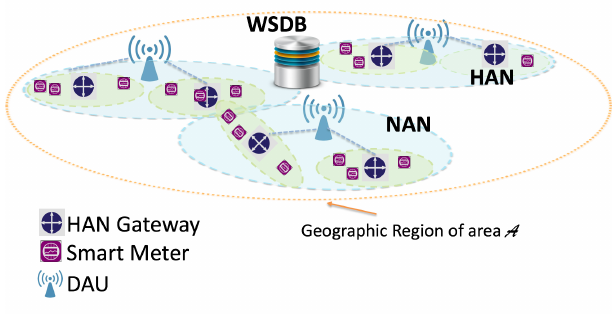
Figure 1. Smart Grid Scenario: Multiple Closely-Located Neighborhood Area Networks